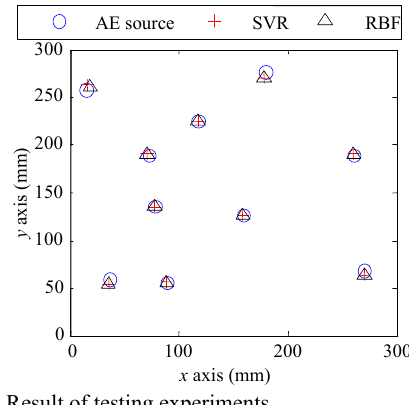
Fig. 4 AE signals.